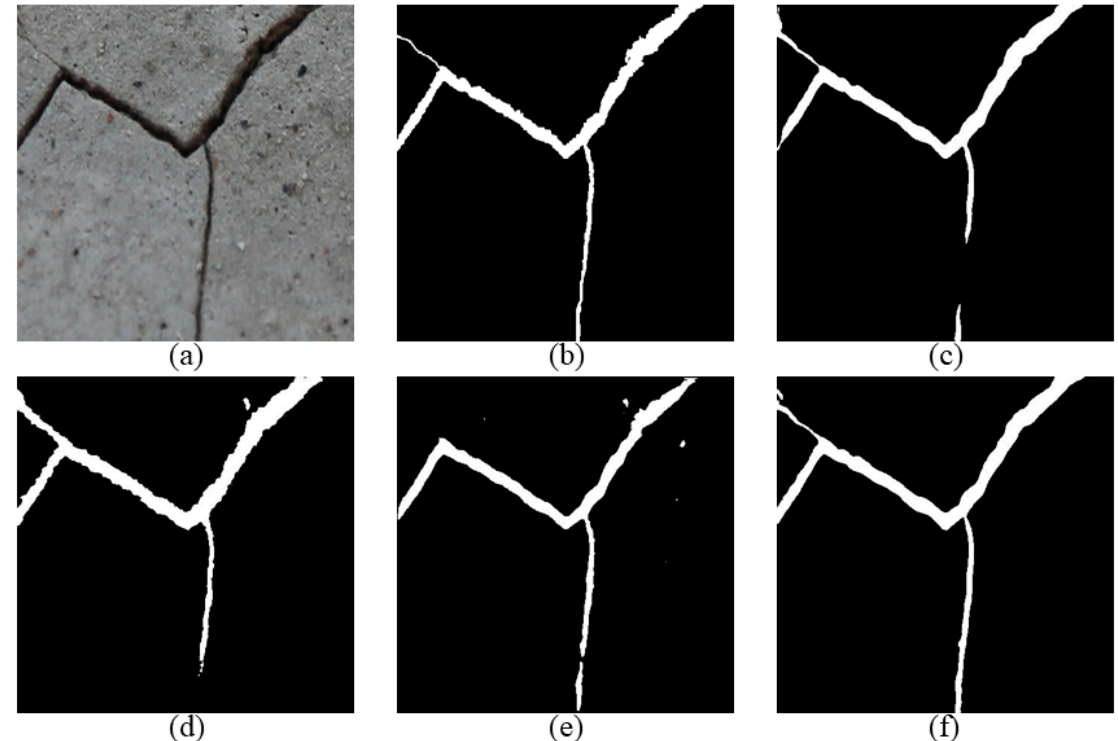
Figure 5. Visualization of experimental results. ( a ) Is an input crack image, ( b ) is the corresponding mask image, ( c ) is the output from U-Net, ( d ) is the output from SegNet, ( e ) is the output from DeepCrack, and ( f ) is the output from SCCD-D32.